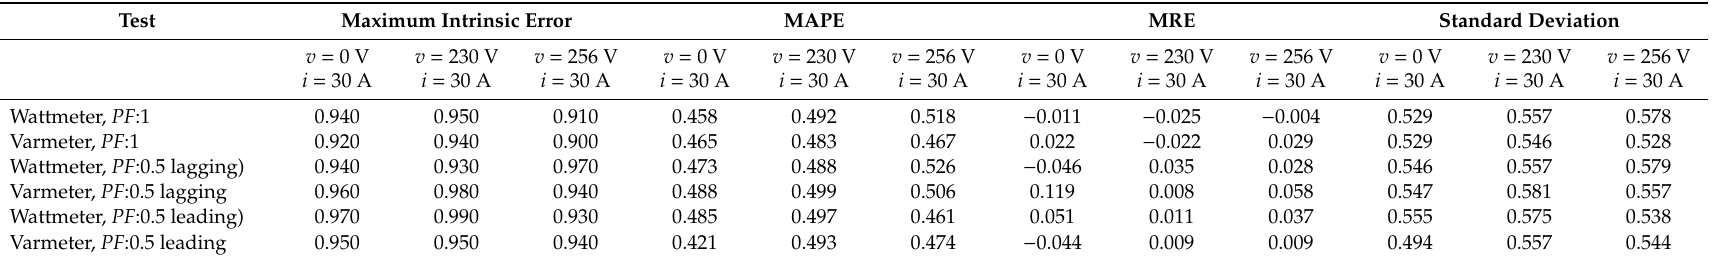
Table 11. PF variation test (wattmeter and varmeter, voltage variation): maximum intrinsic error (%), MAPE (%), MRE (%), and standard deviation (%).